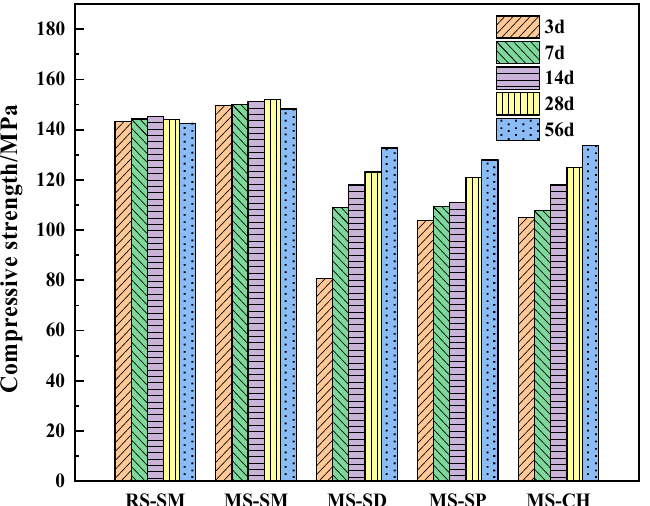
Figure 5. Compressive strength of manufactured sand UHPC at different ages under different curing methods.